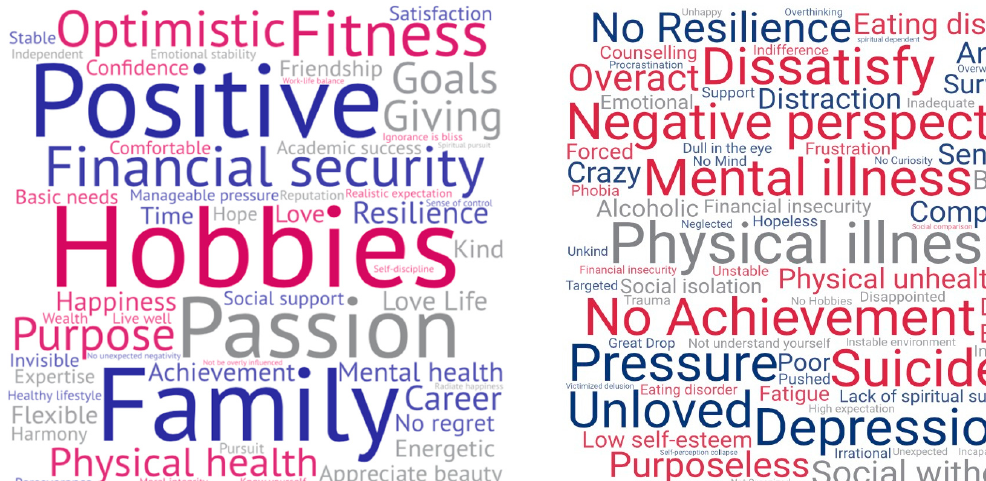
Figure 2. Words and phrases that participants used to describe a person high ( left ) and low ( right ) on wellbeing.